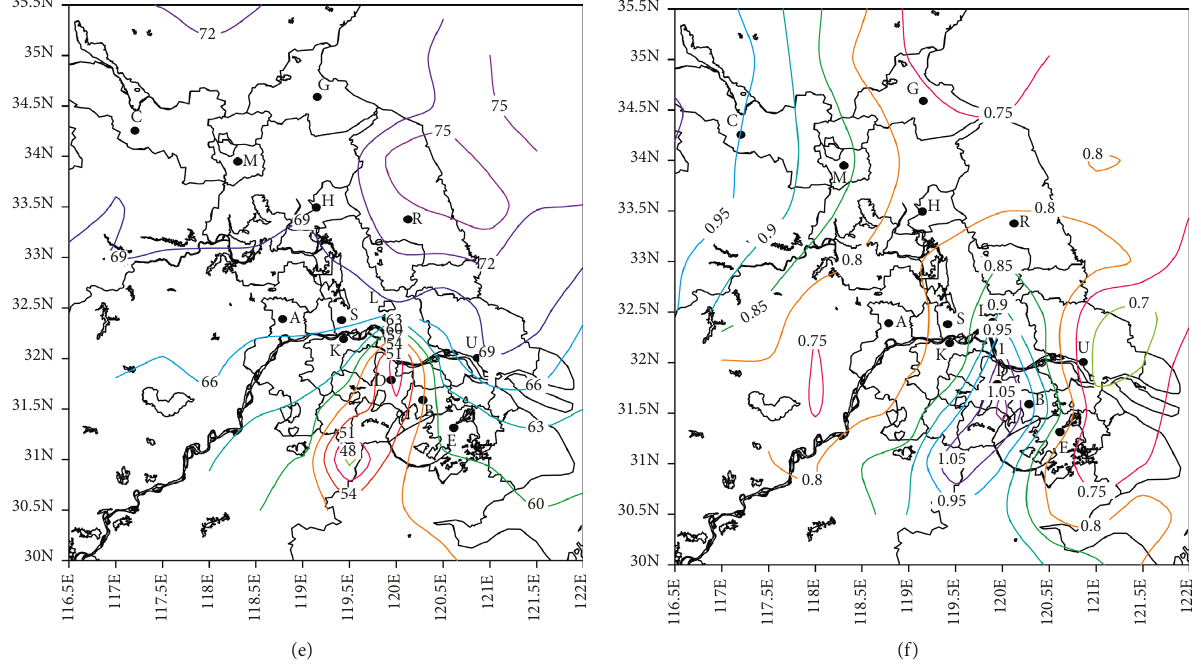
Figure 10: Spatial distribution of annual mean values of primary pollutants in Jiangsu Province between September 2017 and August 2018: (a) PM 2.5 ; (b) PM 10 ; (c) NO 2 ; (d) SO 2 ; (e) O 3 ; (f) CO. Unit: (a)-(e) μ g/m 3 , (f) mg/m 3